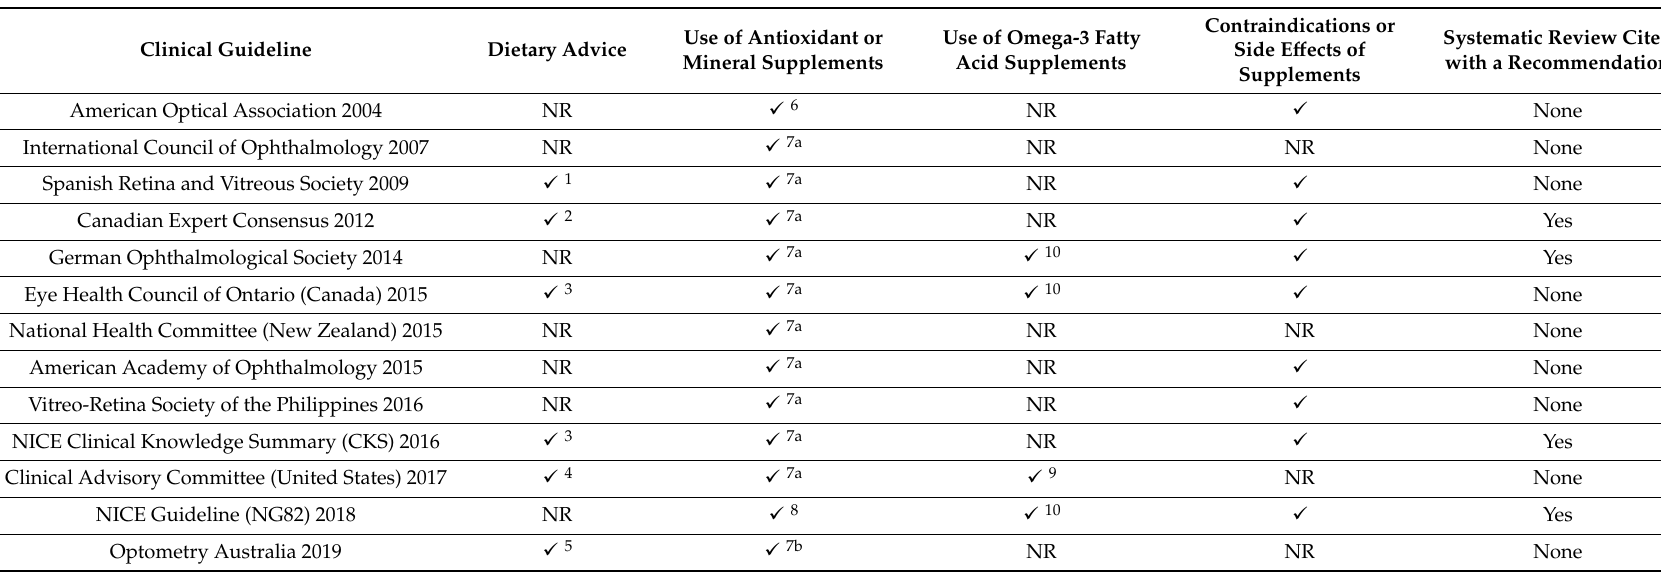
Abbreviations:  , recommendation included; NICE, National Institute for Health and Care Excellence; NR, no recommendation. Guideline recommendations: 1 Diet rich in carotenoids (lutein and zeaxanthin) and omega-3 fatty acids; 2 Dietary intake of antioxidants, docosahexaenoic acid, and omega-3 fatty acids; 3 Diet high in